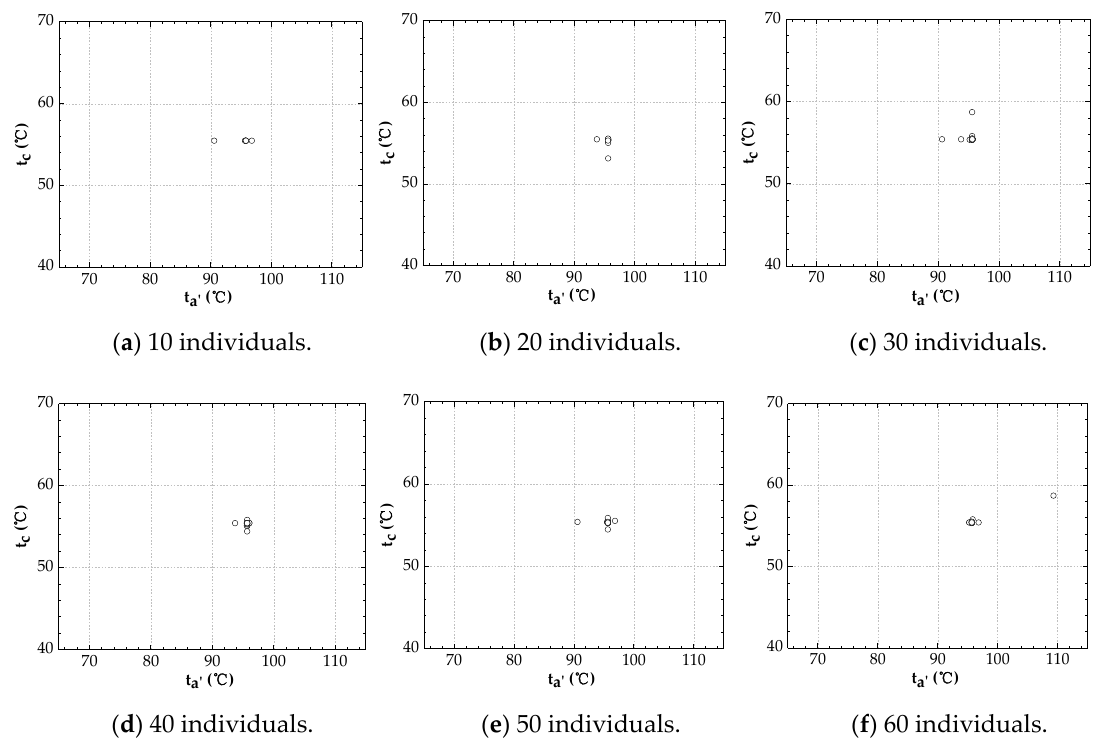
ff erent individuals under 50 evolution Figure 9. The distribution of different individuals under 50 evolution times. Figure 9. The distribution of di